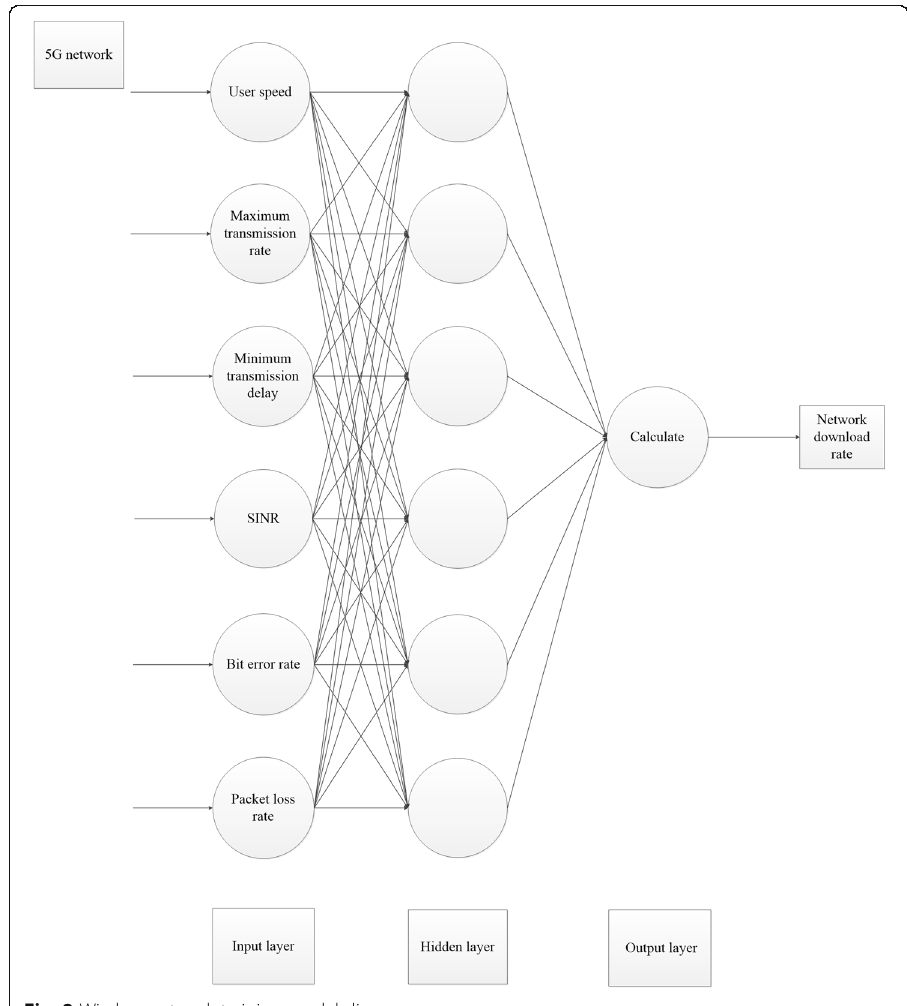
Fig. 2 Wireless network training model